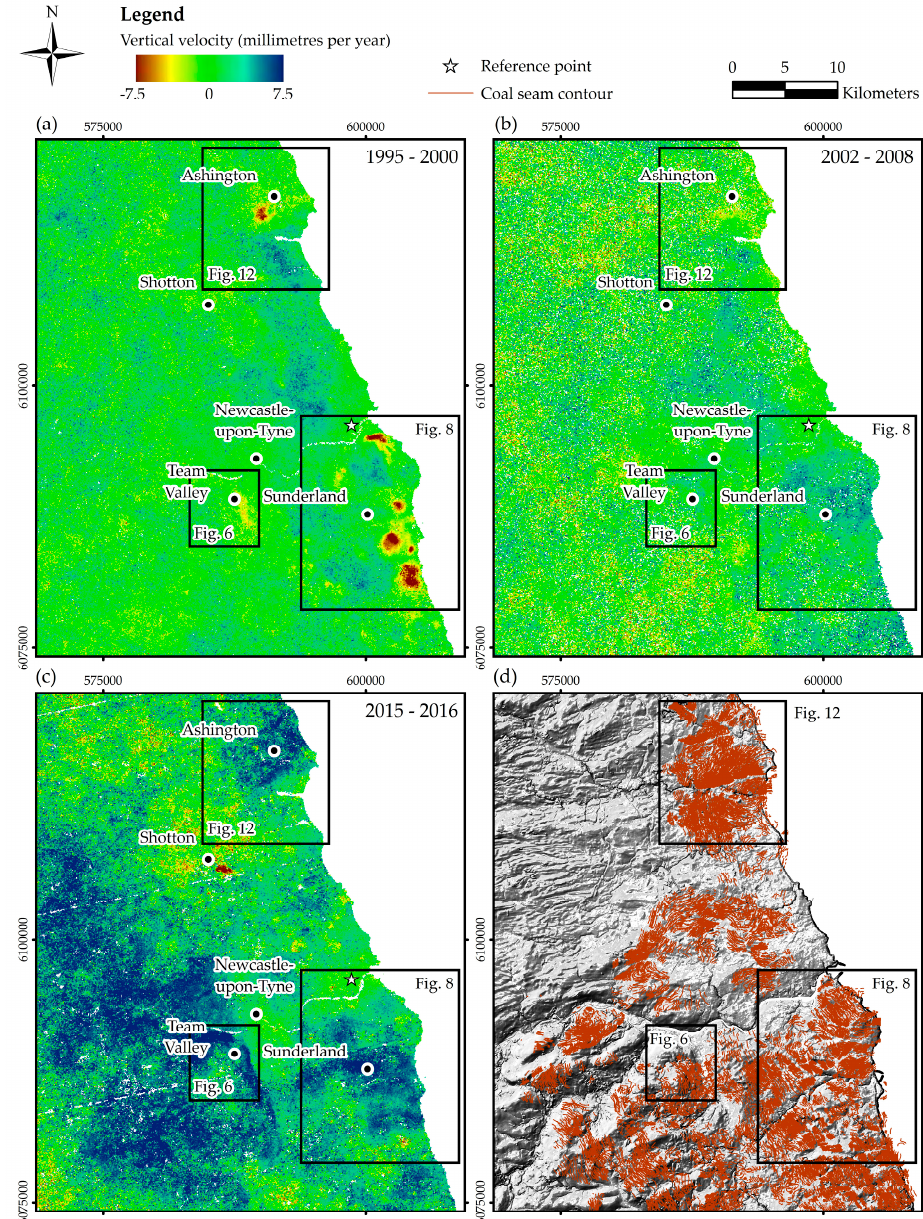
Figure 5. ISBAS average vertical velocities (millimetres per year): ( a ) ERS ( b ) ENVISAT ( c ) Sentinel-1 ( d ) Coal seam contours and